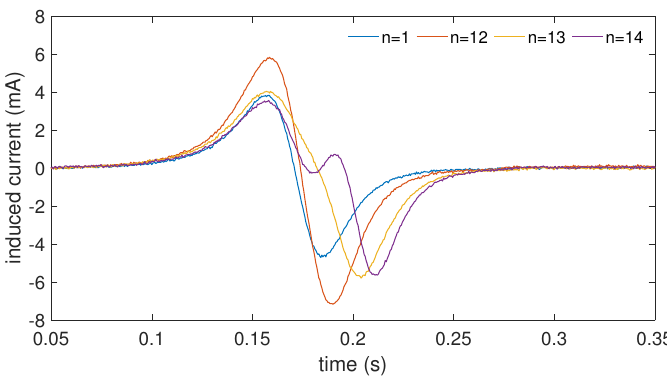
Figure 5. Induced current obtained from a single magnet falling through a